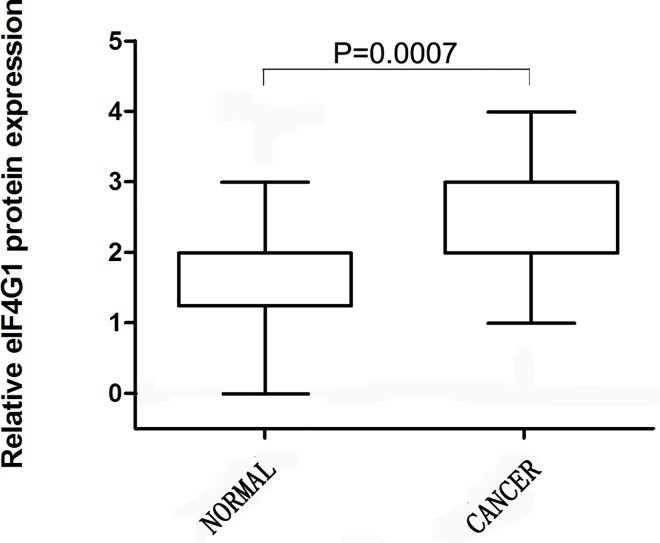
Summary of relative eIF4G1 protein expression in normal and ovarian cancer specimens assessed by IHC.Intensity of eIF4G1 staining was scored from 1 to 4, and an individual box plot was generated to display the distribution of the intensity of eIF4G1 staining for normal ovary samples and ovarian cancer specimens. Immunohistochemical analysis of eIF4G1 in FFPE ovarian cancer samples (n = 134) and normal FFPE ovarian surface epithelial specimens (n = 18). P = 0.0007. (NORMAL: normal FFPE ovarian surface epithelial specimens; CANCER: FFPE ovarian cancer samples).